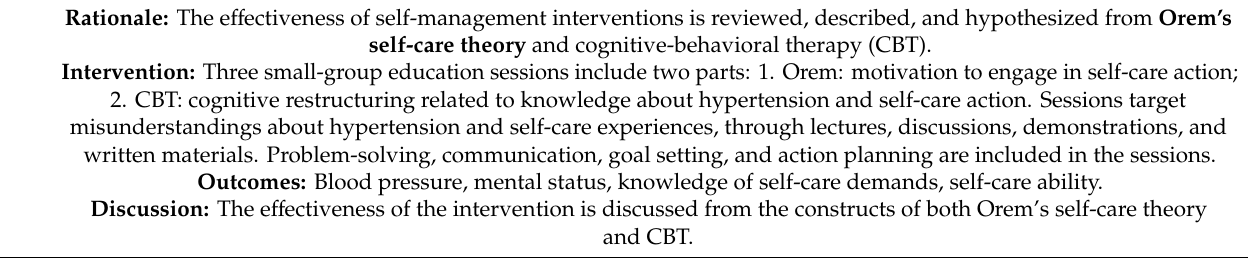
modelling. Outcomes: Self-e ffi cacy, self-care